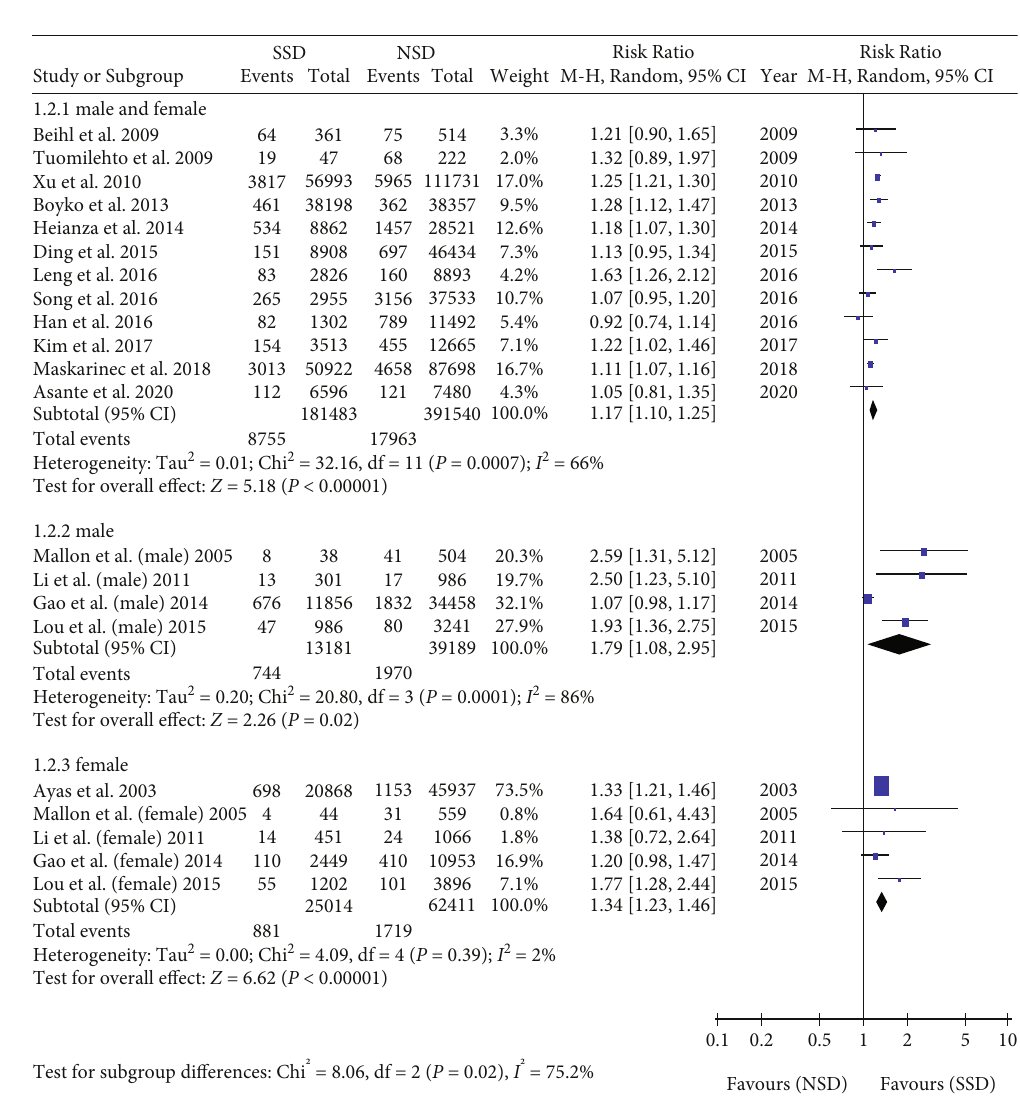
Figure 3: Gender subgroup analysis of the association between SSD and